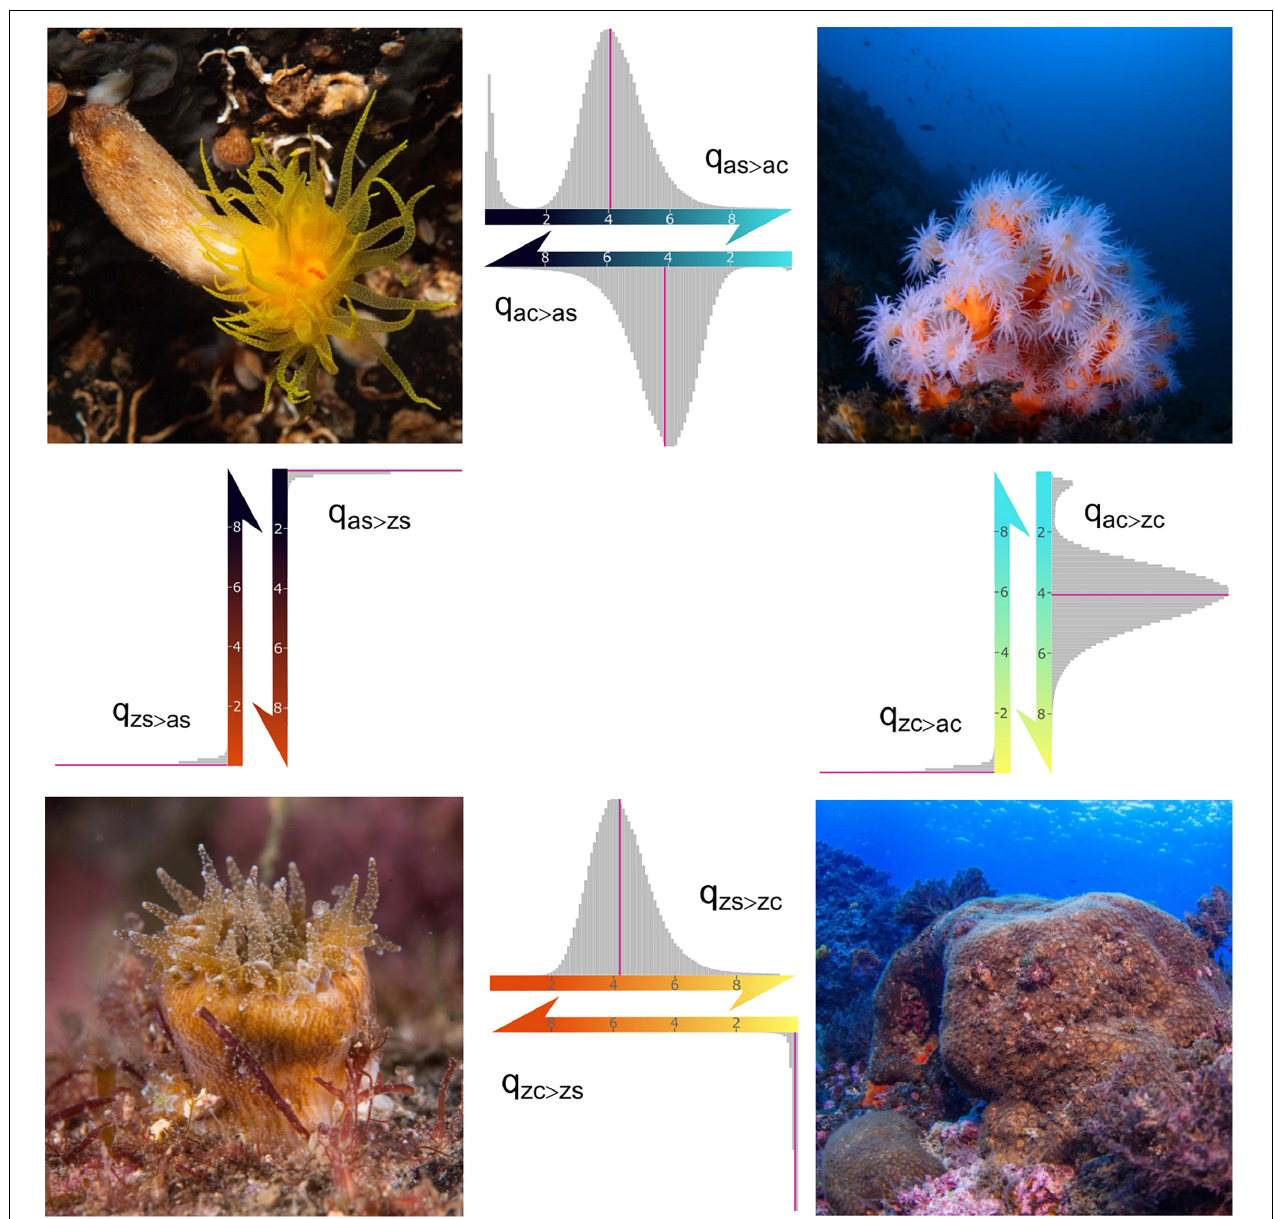
FIGURE 1 | Reversible-jump continuous time Markov model of correlated evolution for symbiosis and coloniality in scleractinian corals. Results from each tree in a sample of 500 trees with 513 species. The four pictures represent an example of the four states included in the model: az-corals/solitary (“as,” up left – Leptosammia pruvoti ), az-corals/colonial (“ac,” up right – Dendrophyllia ramea ), z-corals/solitary (“zs,” down left – Balanophyllia europaea ) and z-corals/colonial (“zc,” down right – Cladocora caespitosa ). Arrows indicate transitions among the four states. Histograms of transition rates across the posterior samples are drawn in a scale 0–10, with arrows pointing toward greater values. Rate values above 10 (0–0.83% of the posterior) were excluded from the histograms to enhance visualization of the results. Pink lines mark median values of transition rates ( q as > ac = 4.29, q as > zs = 0.12, q ac > as = 4.38, q ac > zc = 4.29, q zs > as = 0, q zs > zc = 4.38, q zc > ac = 0, q zc > zs = 0.14). Photographs are courtesy of Luis Sánchez